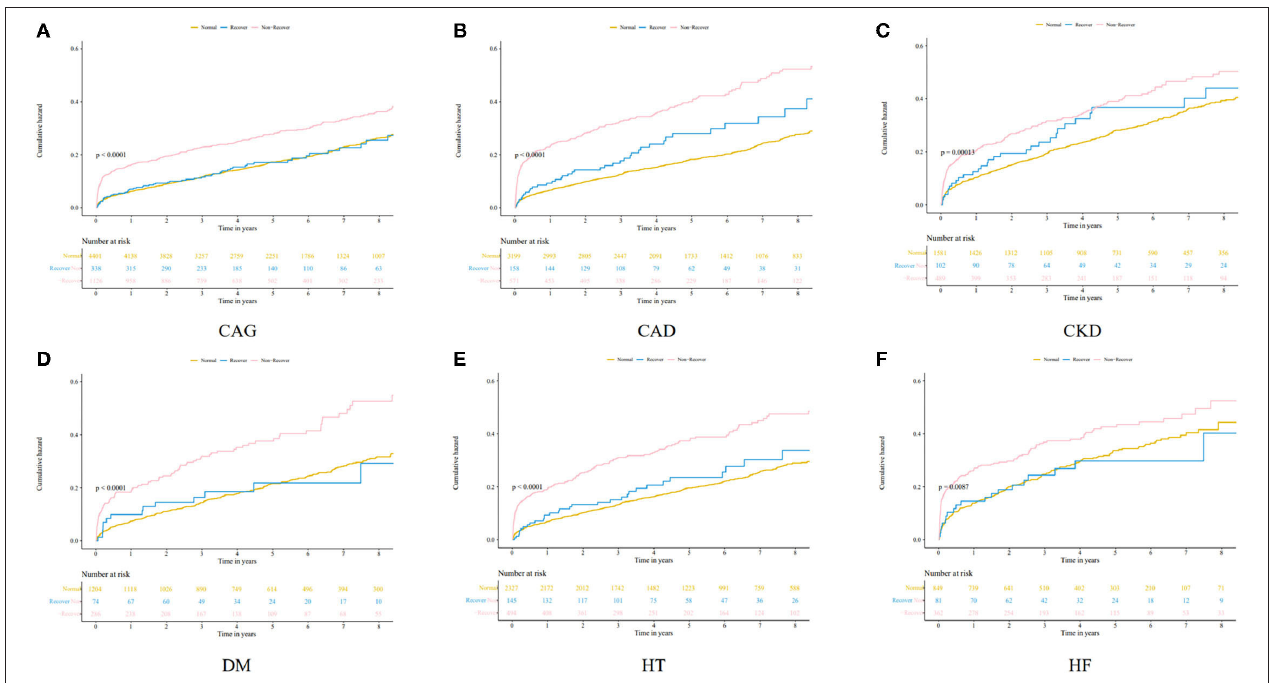
FIGURE 2 | Kaplan–Meier curves for the cumulative probability of mortality stratified according to no contrast-associated acute kidney injury (CA-AKI), recovered CA-AKI, and non-recovered CA-AKI. (A) coronary angiography patients; (B) coronary artery disease patients; (C) chronic kidney disease patients; (D) diabetes mellitus patients; (E) hypertension patients; (F) chronic heart failure patients.